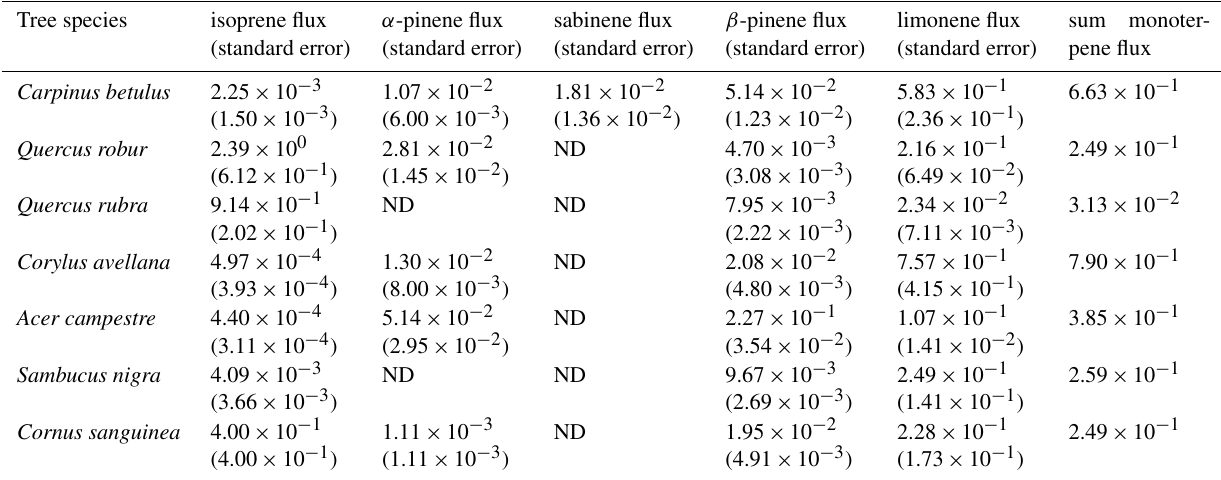
Table 5. Leaf-level isoprene and monoterpene emission (mgm − 2 h − 1 ) recorded using GC–MS from single leaves under basal conditions (temperature: 30 ◦ C and PAR: 1000µmolm − 2 s − 1 ) . ND signifies not